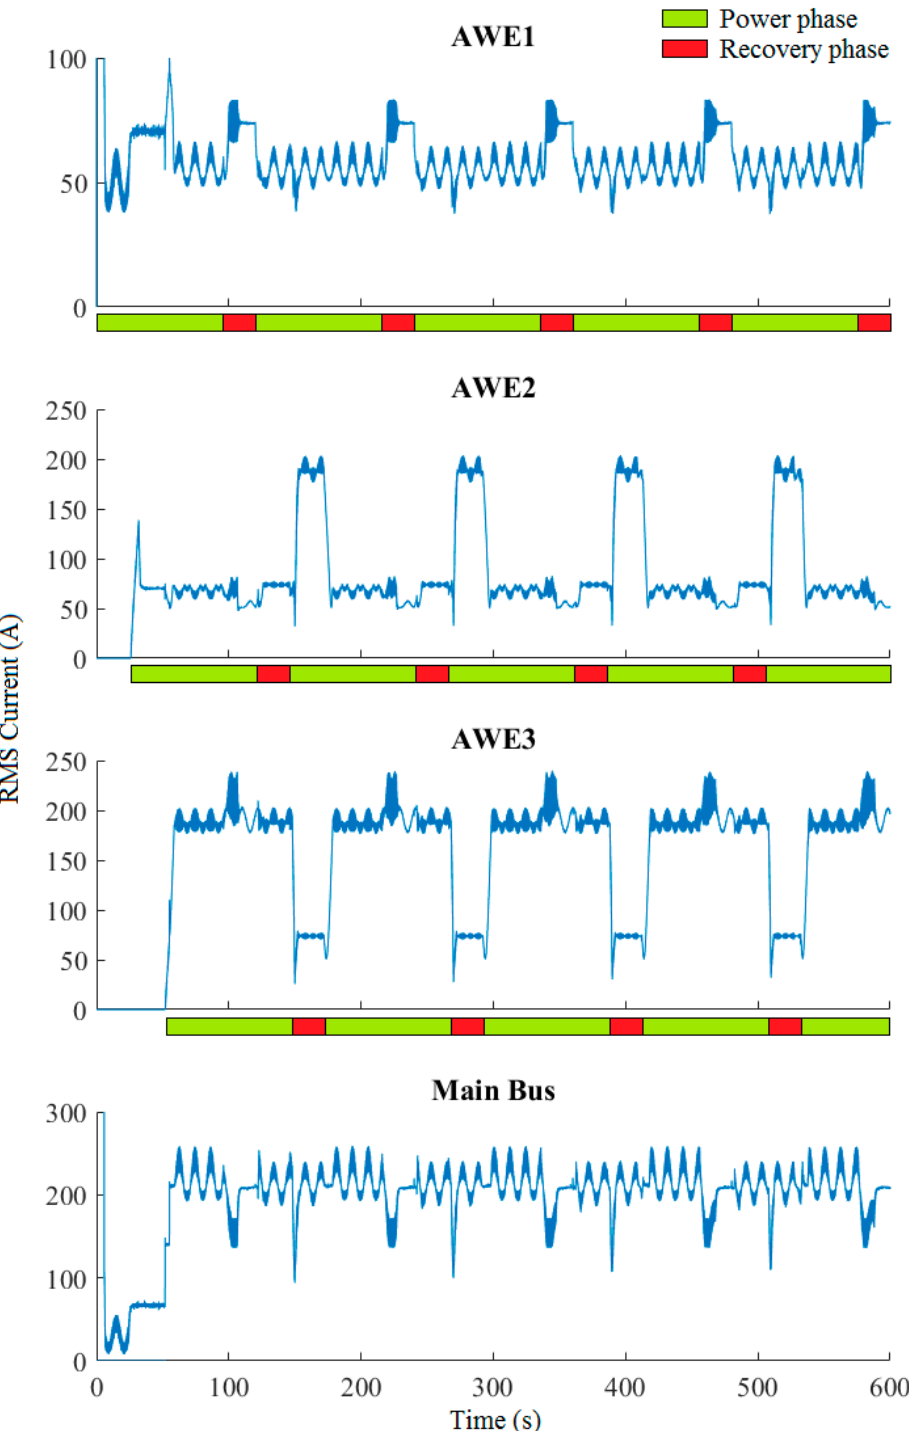
Figure 9. AWE farm currents.